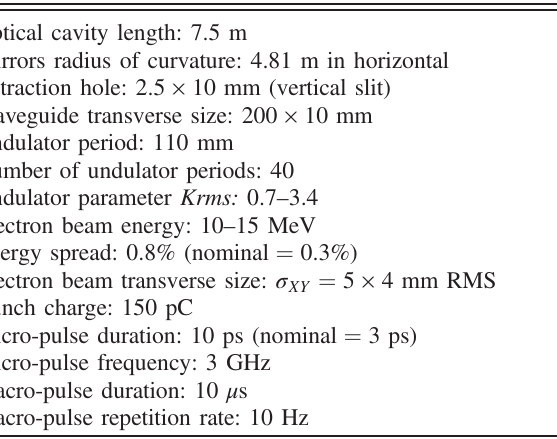
TABLE I. Parameters used for FLARE simulations.